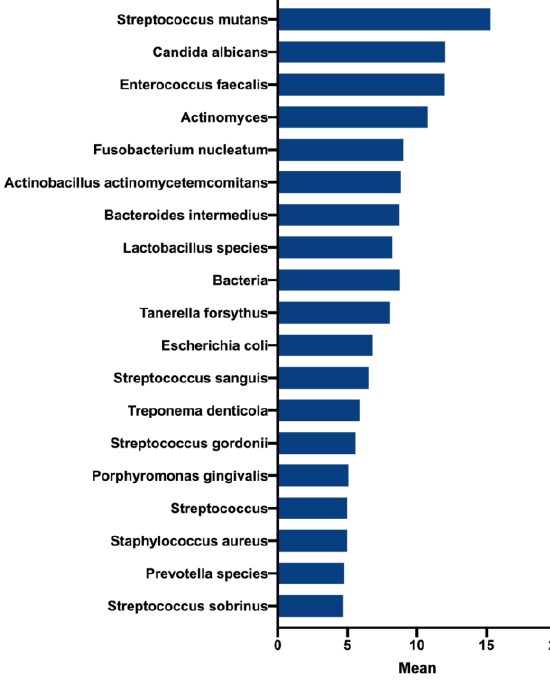
Figure 1. Most frequent terms and their patterns in the literature of endodontic microbiology between 1990 and 2020. The top 20 frequent organisms mentioned in the literature.